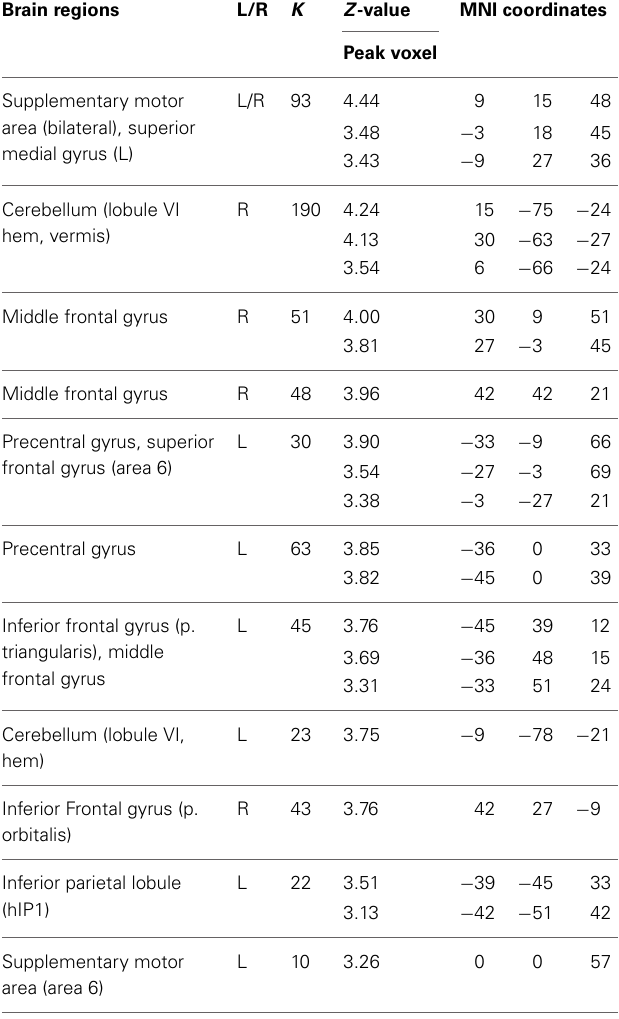
Table 6 | Neural activations for the contrast AU 2 + > AU 0/1. Brain regions L/R K Z -value MNI coordinates